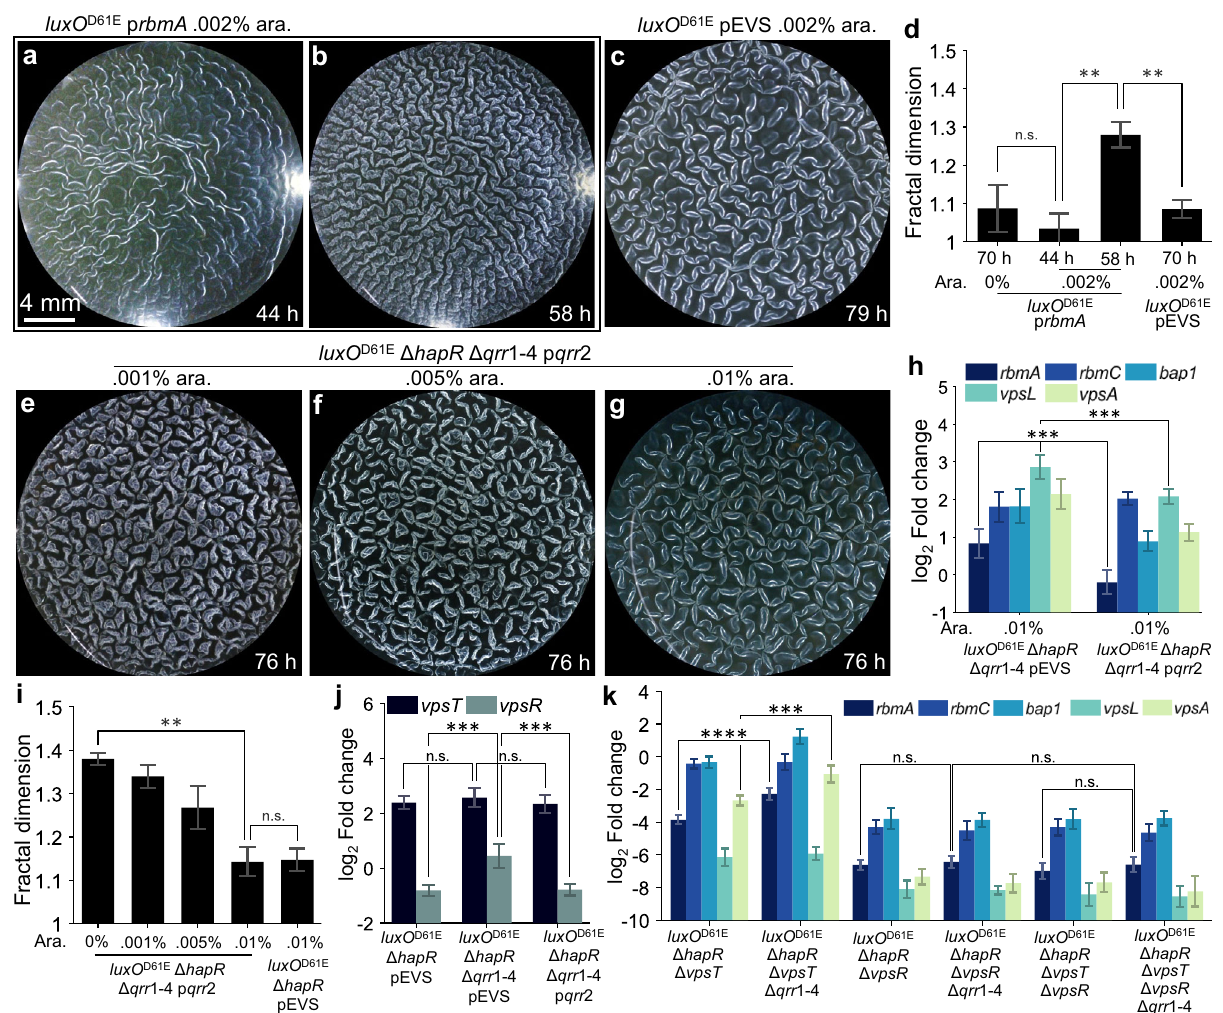
Fig. 6 | Production ofRbmA restoresand Qrr2 represses fractal wrinkling in V. cholerae QS mutants. a , b Pellicle morphologies for the luxO D61E strain carrying p rbmA following induction with 0.002% arabinose were imaged at a 44h in the ridge instability stage and b 58h in the fractal wrinkling stage. c Pellicle morphol- ogies for the luxO D61E strain carrying the empty pEVS vector at 79h. d Fractal dimensions of the wrinkle features for the luxO D61E strain carrying p rbmA or the empty pEVS vector at the indicated time points and arabinose concentrations. e – g Pellicle morphologies for the luxO D61E Δ hapR Δ qrr 1-4 strain carrying p qrr 2 fol- lowing induction with the indicated arabinose concentrations at 76h of growth. h Expressionof the indicatedgenes inthe designated strains wasassessed byqRT- PCR. Data are presented relative to that from wildtype V. cholerae . i Fractal